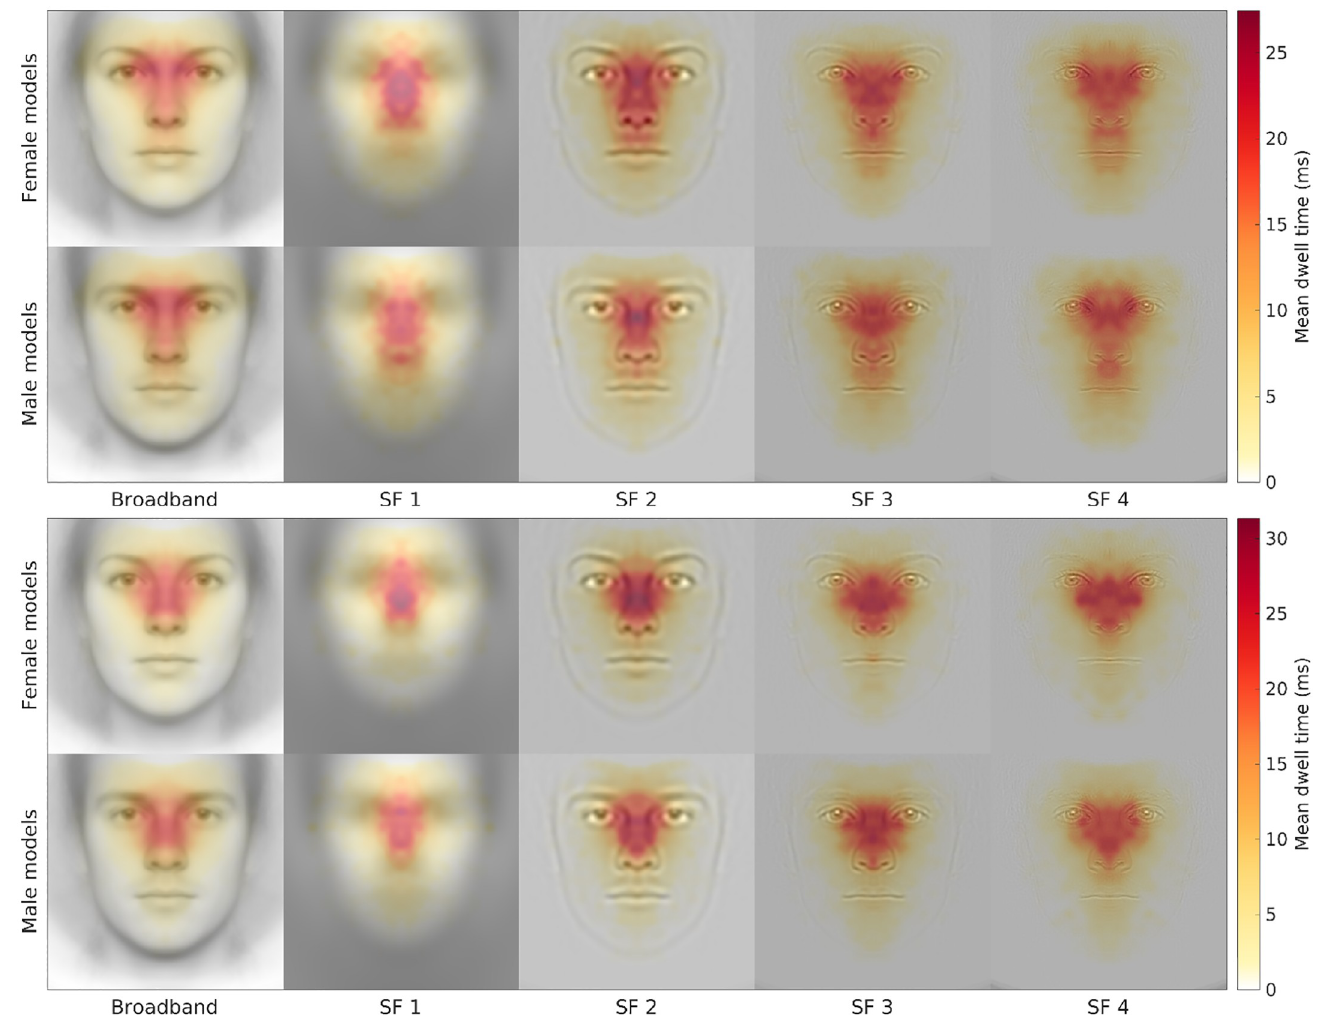
Fig 7. Mean dwell times of gaze (temperature scale indicates ms) between looking at female versus male models superimposed to the morphs generated from the Oslo Face Database, split by Location (Top panel: Oslo; Bottom panel: Tokyo) and the spatial frequency